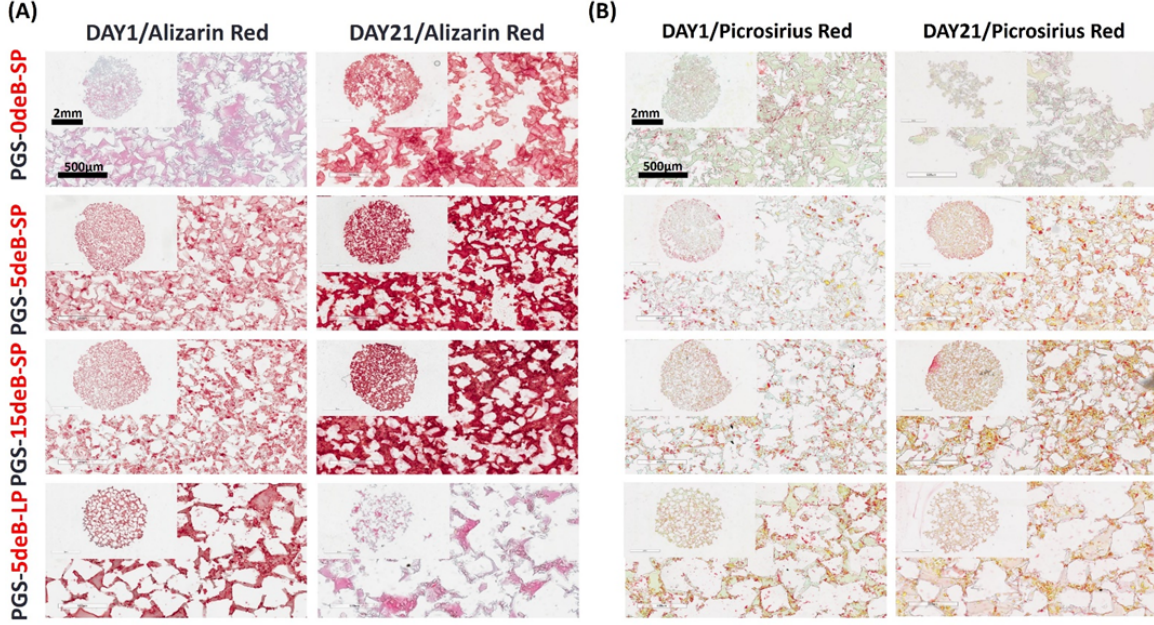
Figure 13. Mineralization was determined with alizarin red staining ( A ), and collagen production was evaluated with picro sirius red staining on days 1 and 21 of the culture ( B